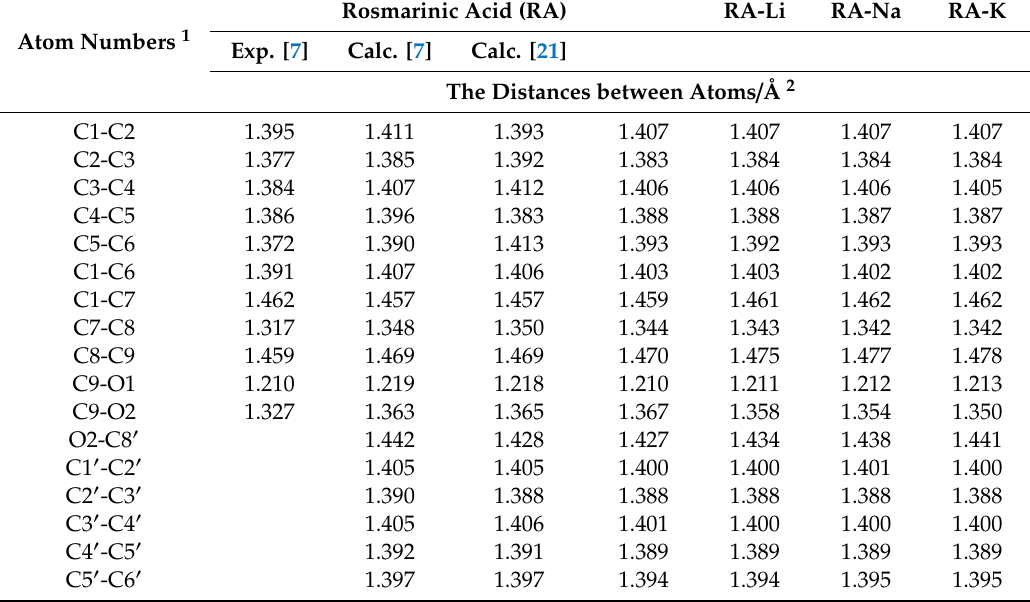
Table 1. The distances between atoms (Å) and the angles between bonds ( ◦ ) in rosmarinic acid and